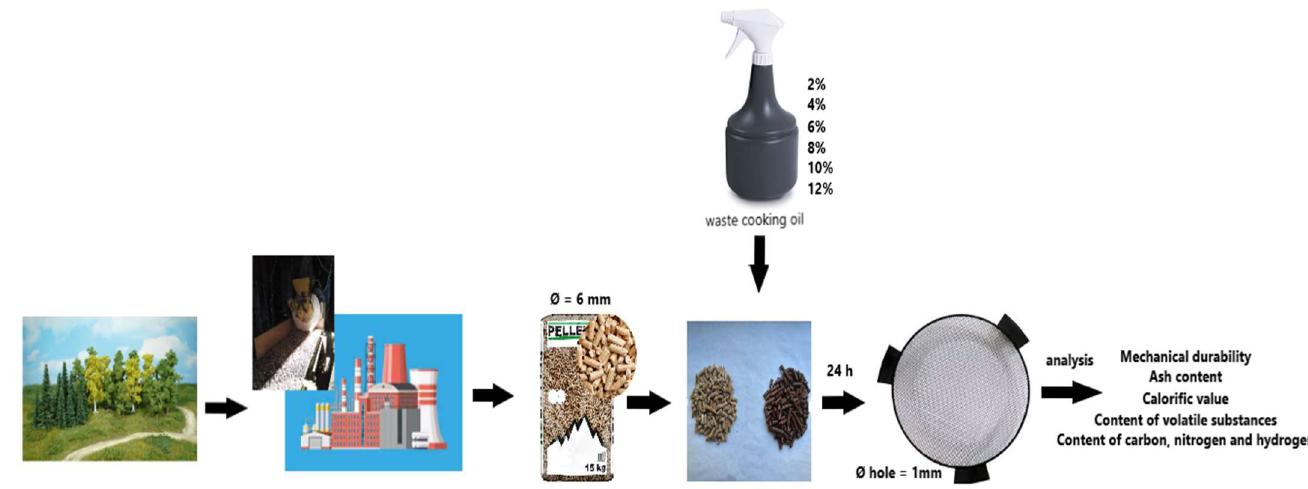
Figure 2. The scheme of the experiment.